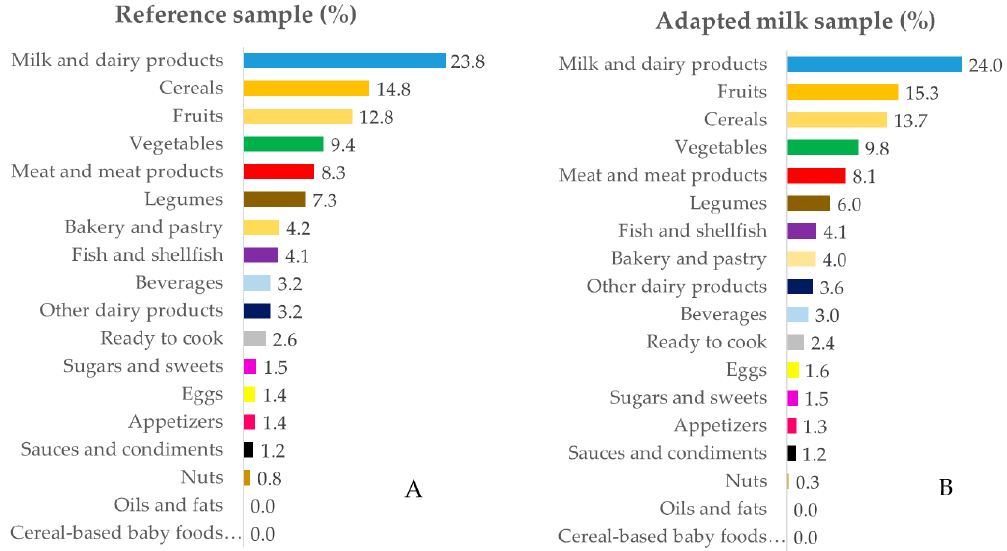
Figure 3. Percentage of the 18 food groups sources, in terms of the total magnesium intake (%), among the reference sample ( A ) and the adapted milk consumer sample ( B ) of the Spanish Pediatric Population (EsNuPI) study.